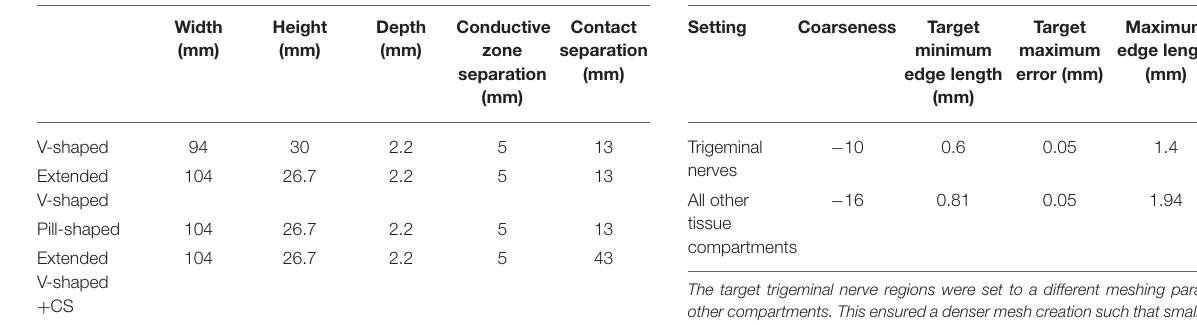
TABLE 1 | Electrode dimensions and contact separation. TABLE 2 | Mesh properties of the FE